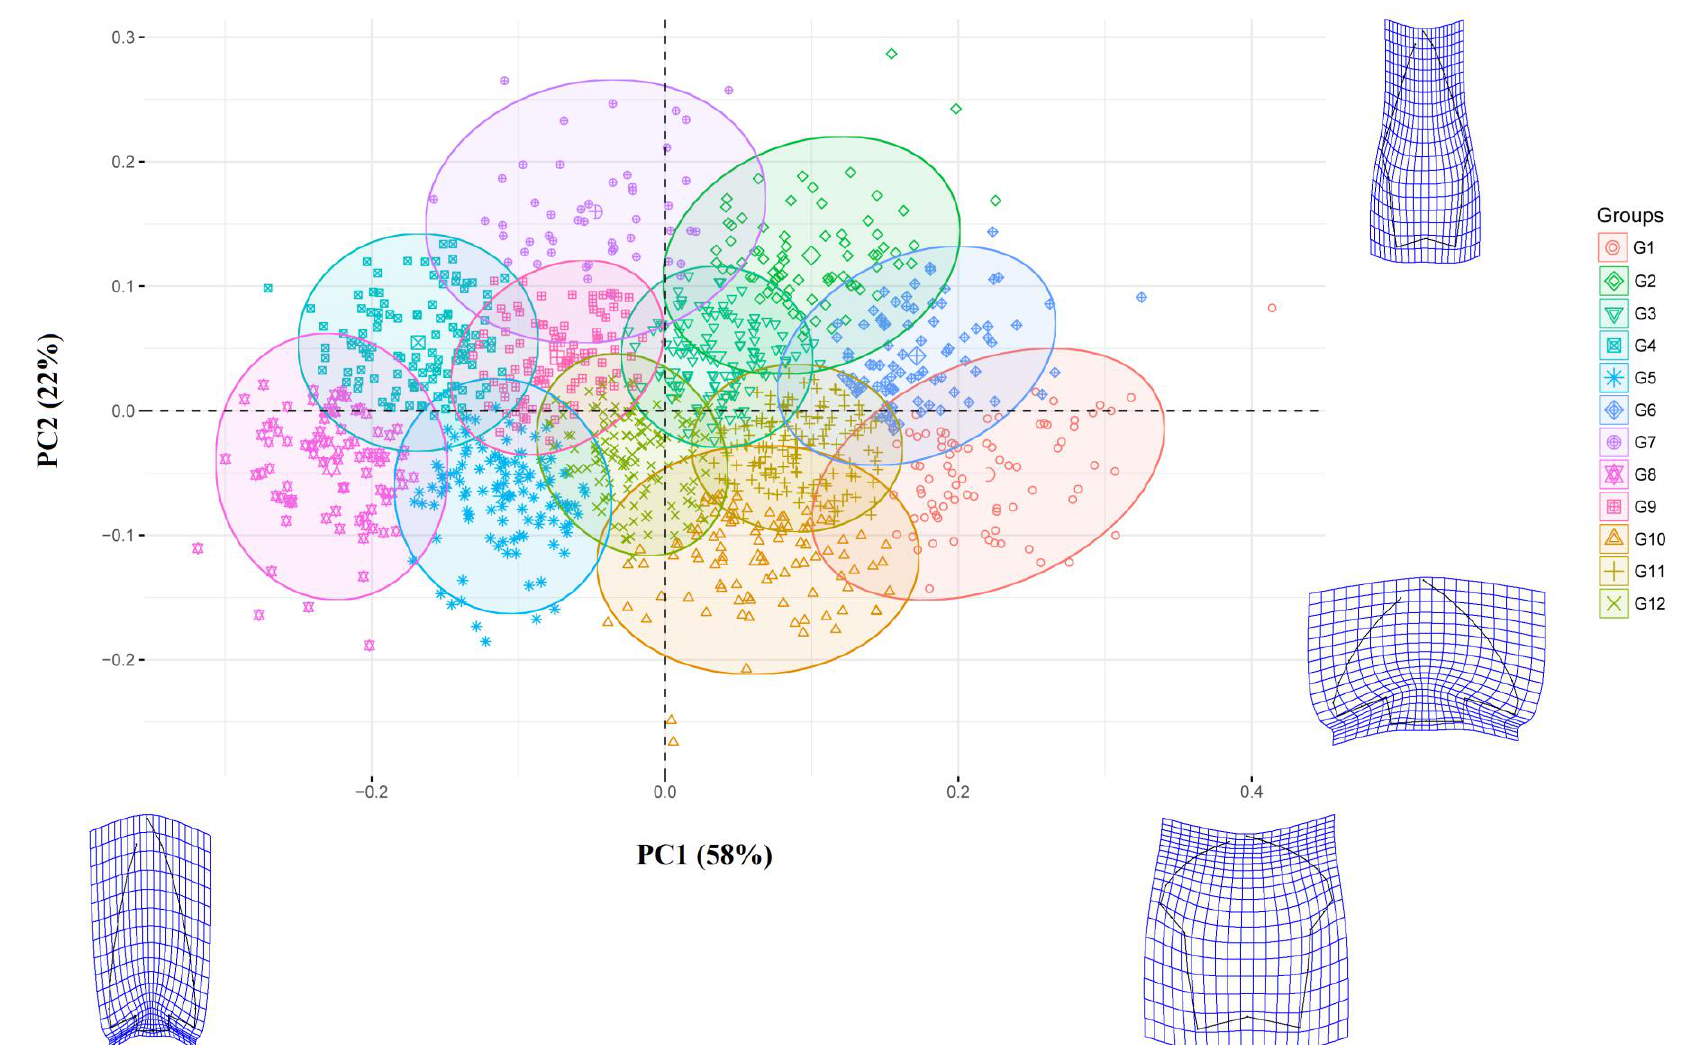
Figure 5. First two axes of principal component analysis on projectile points shape coordinates. Groups selected by K-means are depicted with 95% concentration ellipses. At the bottom: main shape deformation of first axis. At the right: the second axis shape